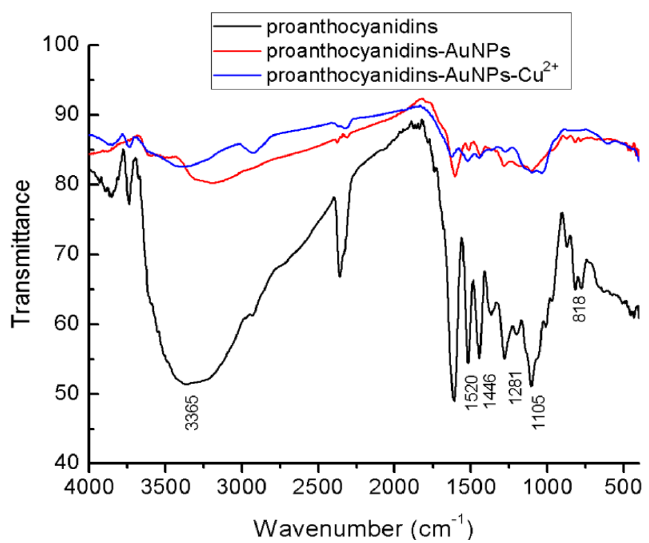
Figure 3. FTIR absorption spectra of pure proanthocyanidins and the proanthocyanidin-functionalized gold nanoparticles.